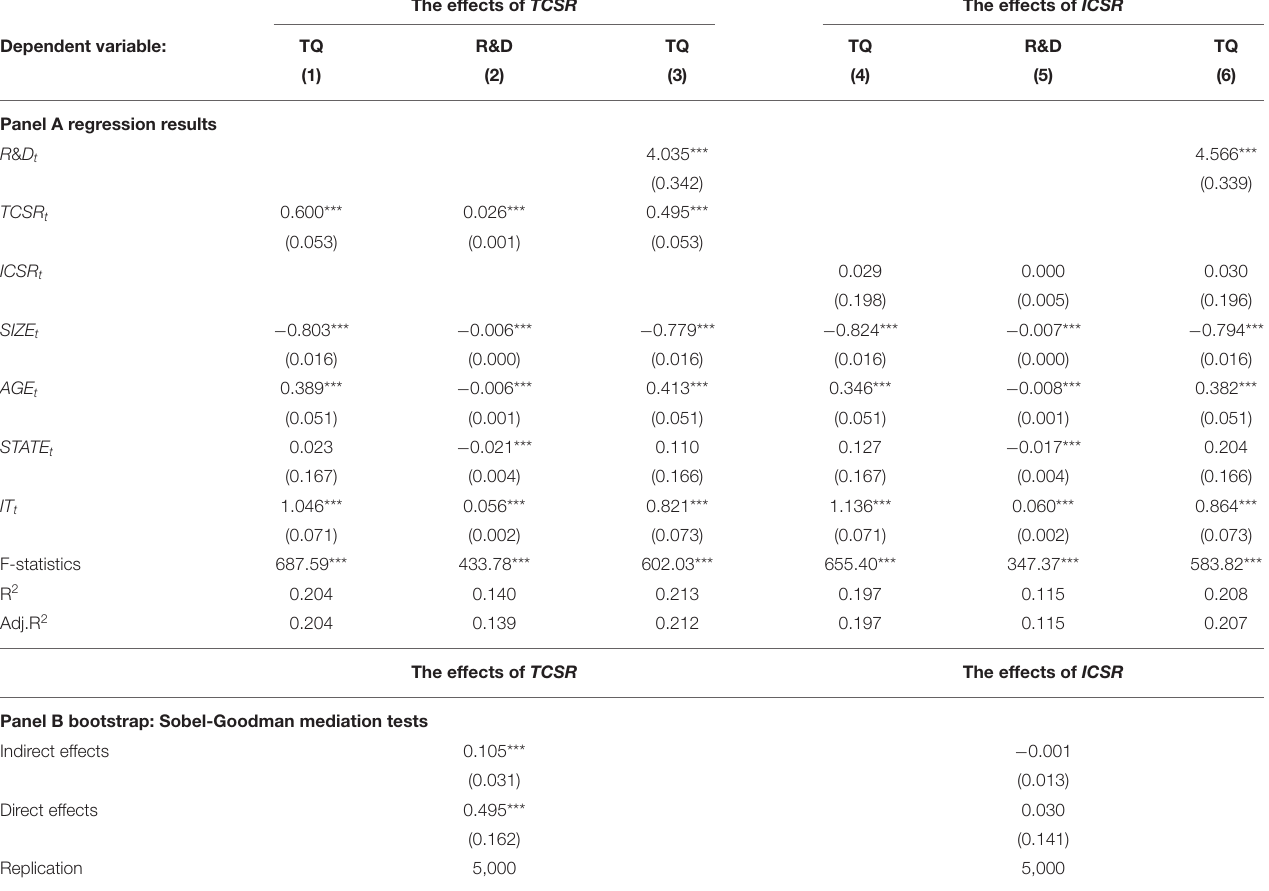
TABLE 3 | CSR performance and CFP: The mediating effects of